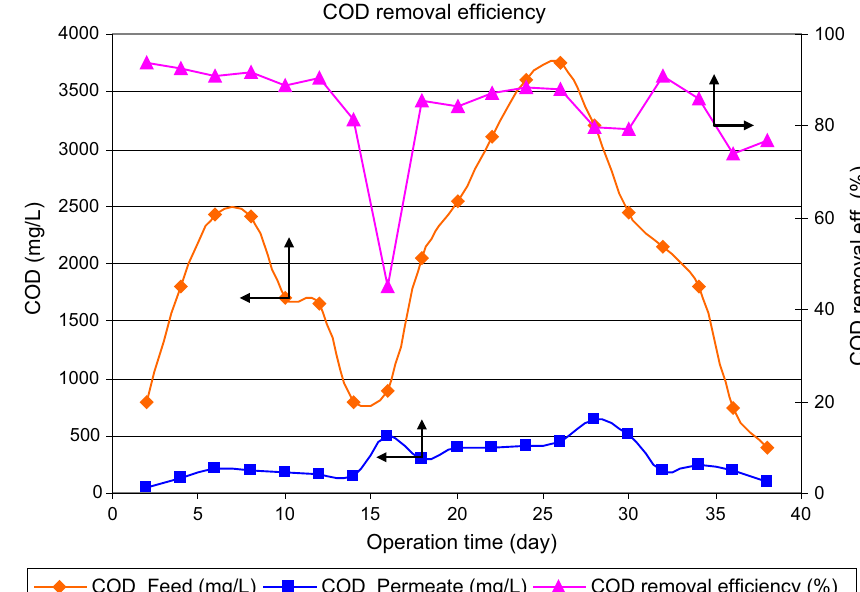
Fig. 4 COD removal efficiency of pilot